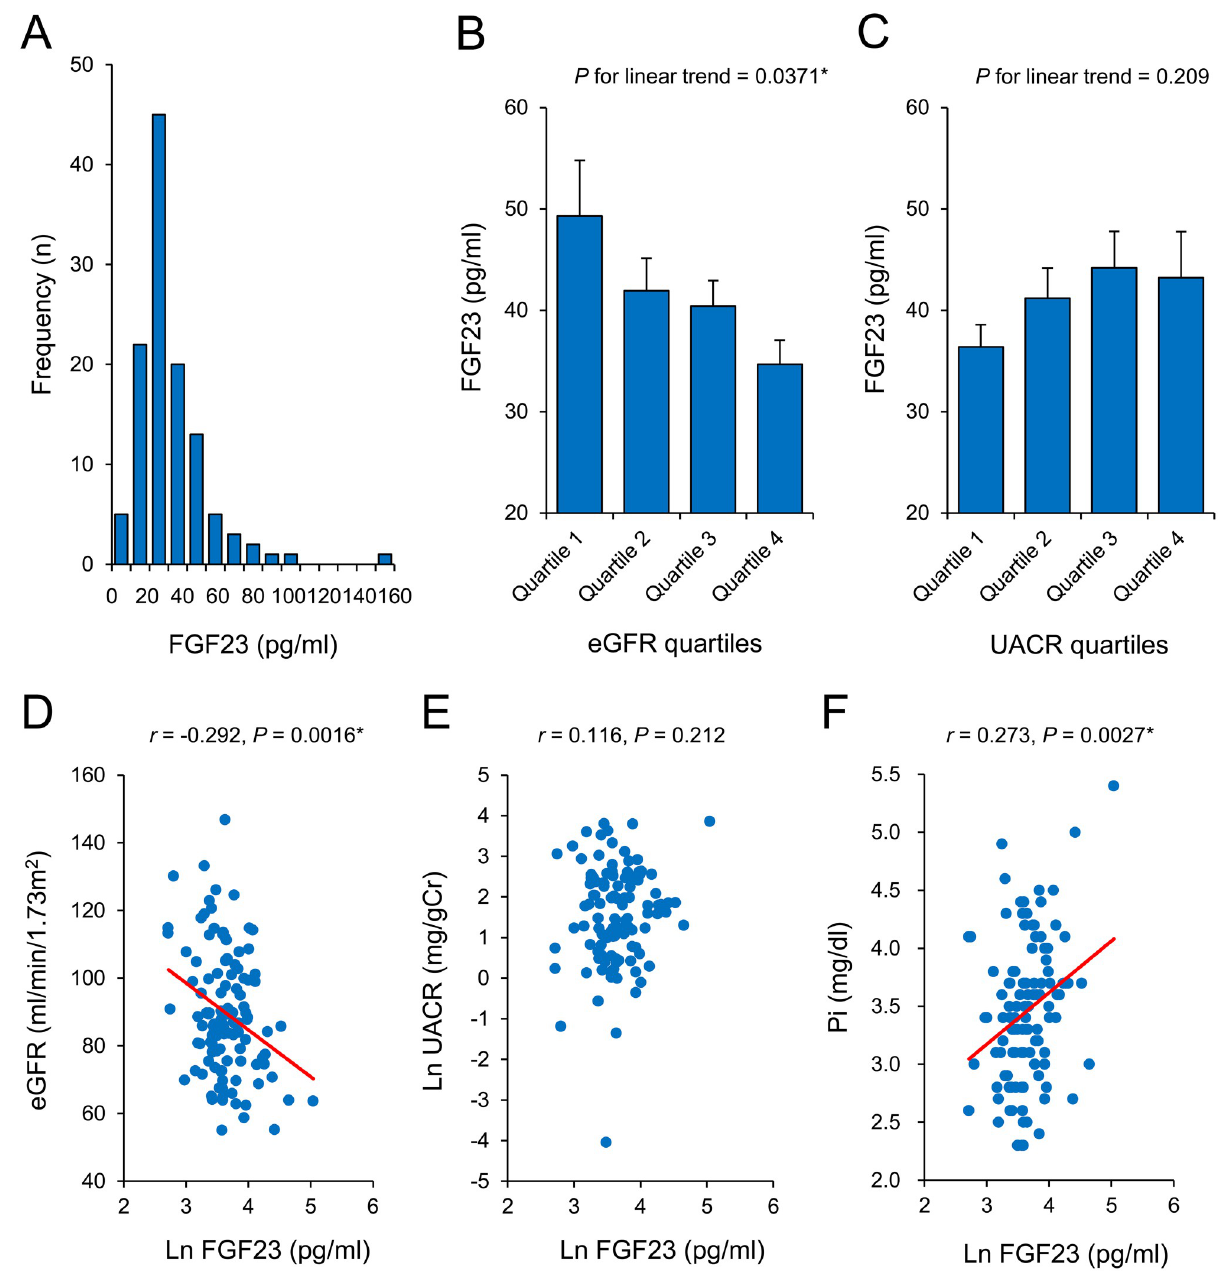
Fig 1. Serum FGF23 was negatively associated with the eGFR, but not the UACR, in patients with T1D. (A) The distribution of serum full-length FGF23 levels. The median (Q1, Q3) serum FGF23 level was 36.6 (30.7, 47.1) pg/ml. (B and C) Descending quartiles of the eGFR were associated with significantly increased mean ( ± SE) serum FGF23 levels ( P for linear trend = 0.0371) (B). On the other hand, ascending quartiles of UACR were not significantly associated with increased mean ( ± SE) serum FGF23 level ( P for linear trend = 0.209) (C). The Jonckheere-Terpstra trend test was used in these analyses. (D-F) The associations between the serum FGF23 level and the eGFR ( r = -0.292, P = 0.0016) (D), UACR ( r = 0.116, P = 0.212) (E), serum Pi level ( r = 0.273, P = 0.0027) (F). Non-normally distributed variables were subjected to natural logarithmic transformation. Pearson’s correlation coefficients were used in these